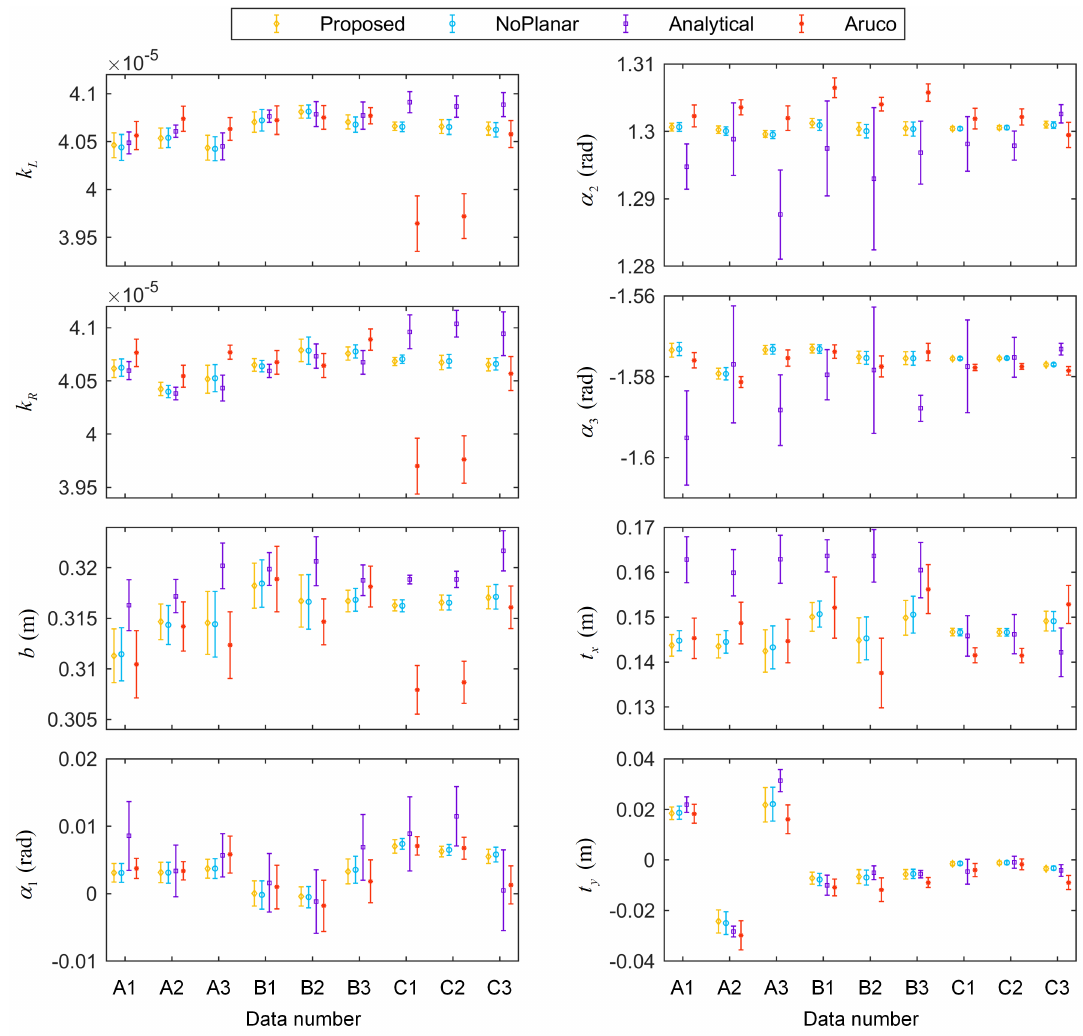
Figure 7. Results of calibration parameters with standard